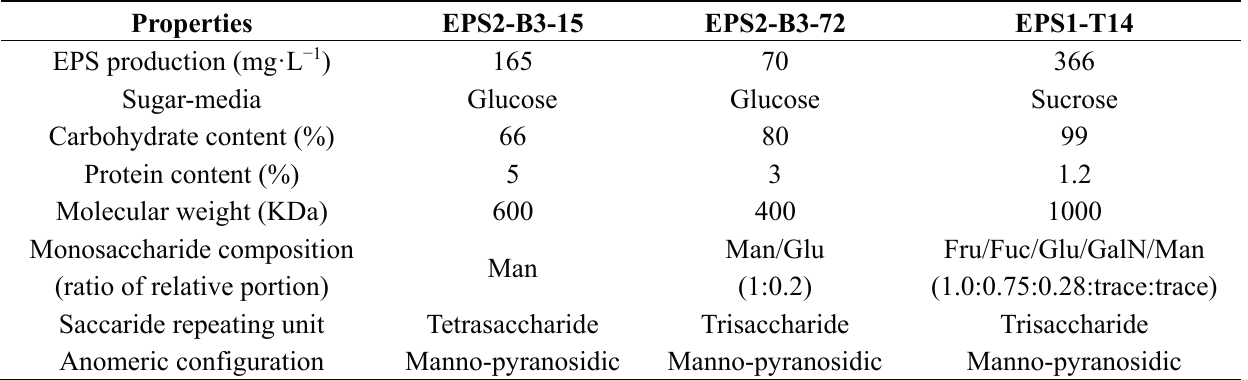
Table 3. Chemical characterization of EPSs produced by bacilli isolated from Eolian shallow